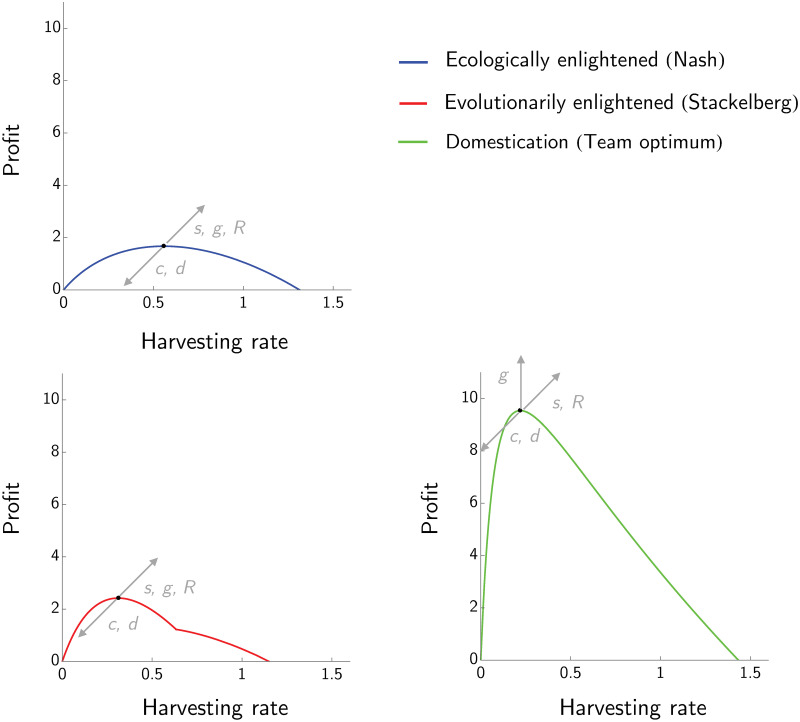
Sensitivity analysis of the three equilibria for the case where the manager can set only the harvesting rate.Sensitivity analysis showing how profit and harvesting rates change with the intensity of density dependence R, the maximum fecundity rate s, the natural mortality rate d, the growth rate of juveniles g and the cost of fishing c (z = 6). Arrows pointing up (down) indicate that the profit is increasing (decreasing) when the corresponding parameter increases, arrows pointing to the right (left) indicate that the harvesting rate at the equilibrium is increasing (decreasing) when the corresponding parameter increases. The profit at the ecologically enlightened and evolutionarily enlightened equilibria are directly proportional to s, R and g and inversely proportional to c and d. The harvesting rate at both equilibria increases when s, g or R increase and decreases when c or d increase. The profit at domestication equilibrium increases with s, R and g and decreases with c and d. The corresponding harvesting rate increases with R and s and decreases with c.